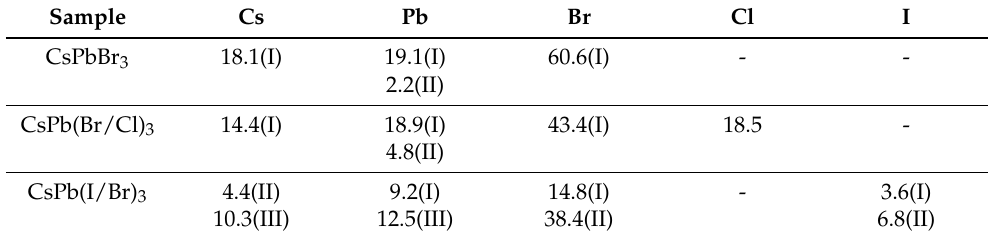
Table 2. Chemical composition of PNCs in at.% calculated from XP spectra (Figure 6) .